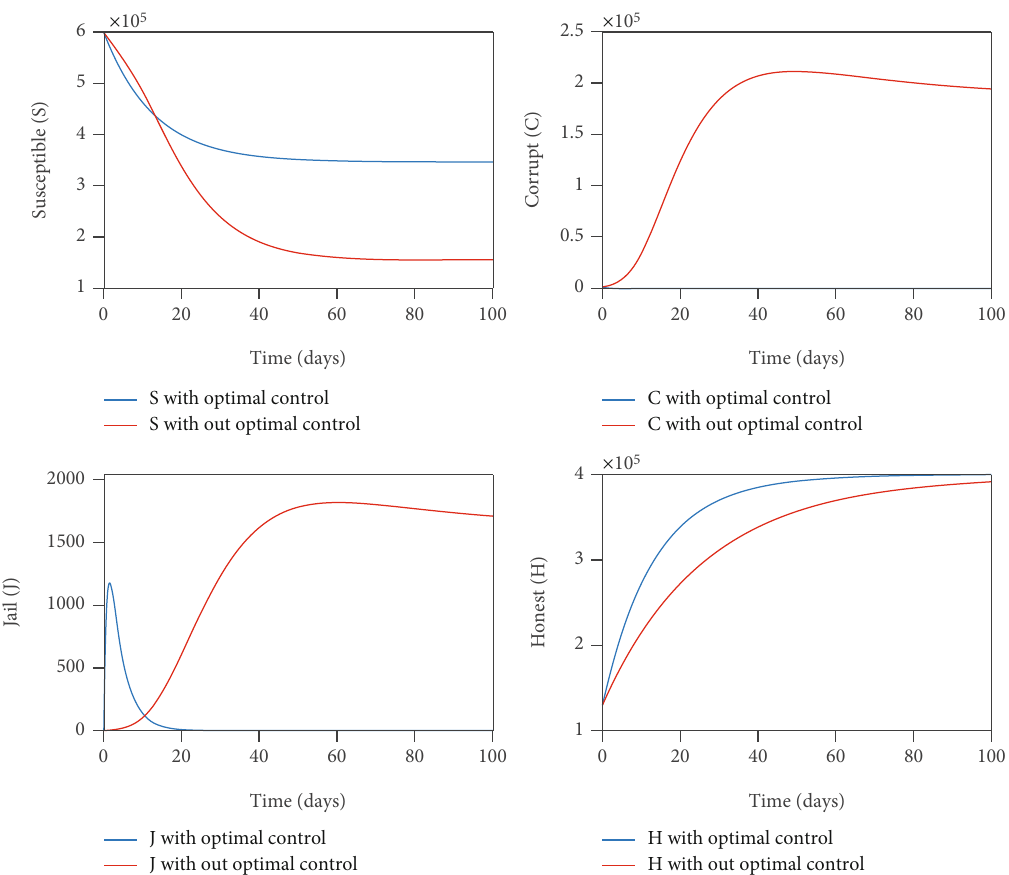
β = 0 : 07 , δ = 0 : 0012 , 1 and u 2 when